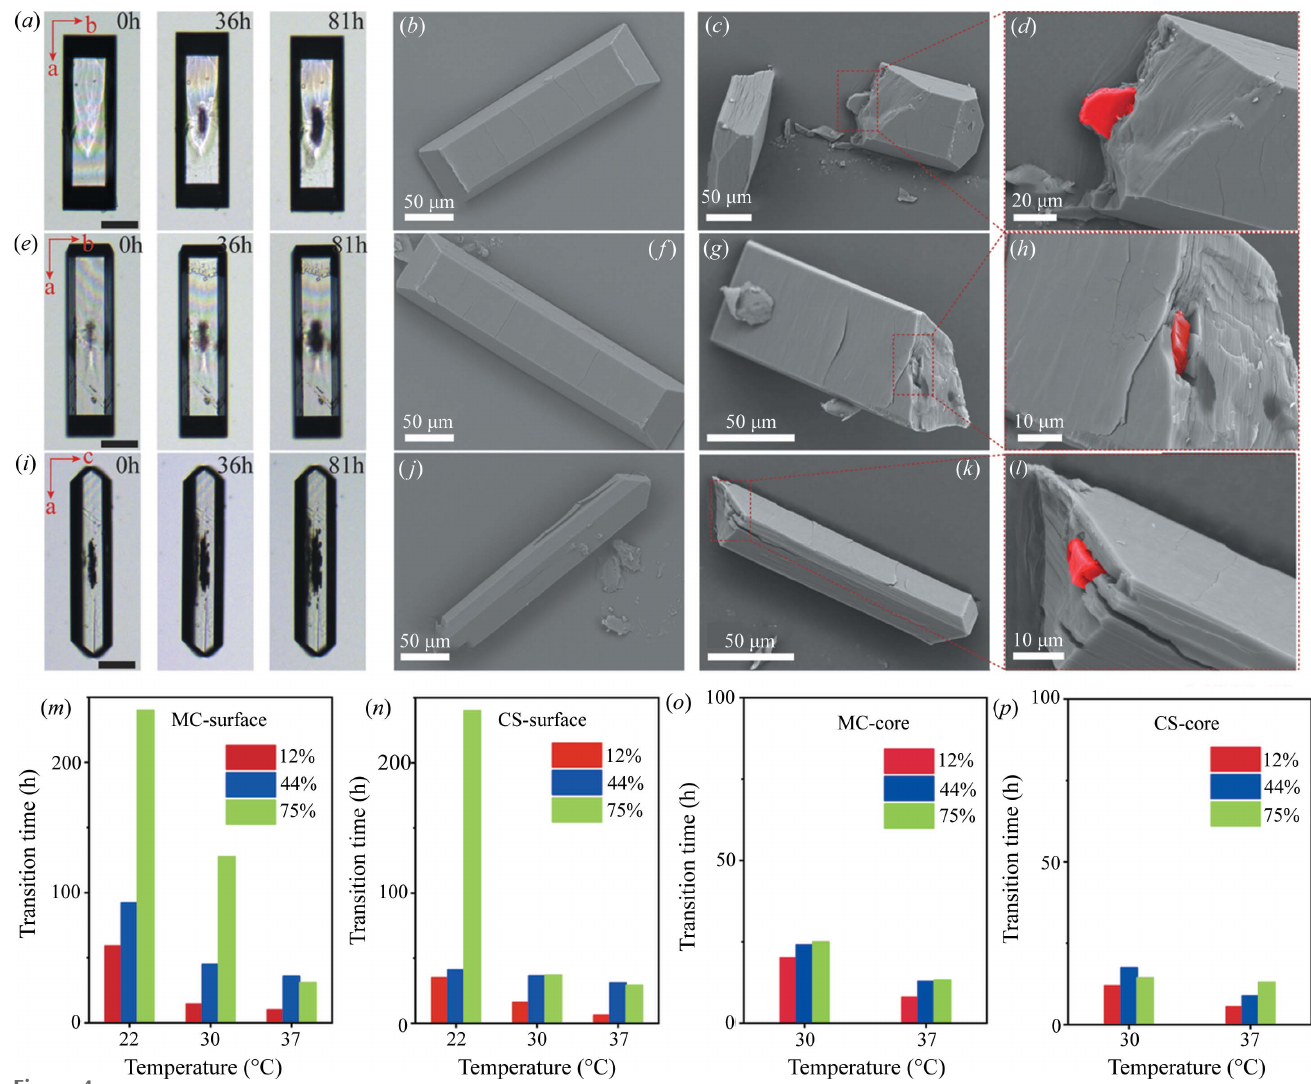
Figure 4 Core-shell phase transition in air. Morphology evolutions of ( a ) MC and [( e ), top view; ( i ), side view] CS in air at 37 (cid:3) C and RH 75%. The scale bar is 50 m m. SEM images of surface and cross-section of ( b )–( d ) MC, ( f )–( h ) and ( j )–( l ) CS selected after 36 h. The onset transition time of ( m ), ( o ) MC and ( n ), ( p ) CS in air at temperatures from 22 to 37 (cid:3) C and RHs ranging from 12 to